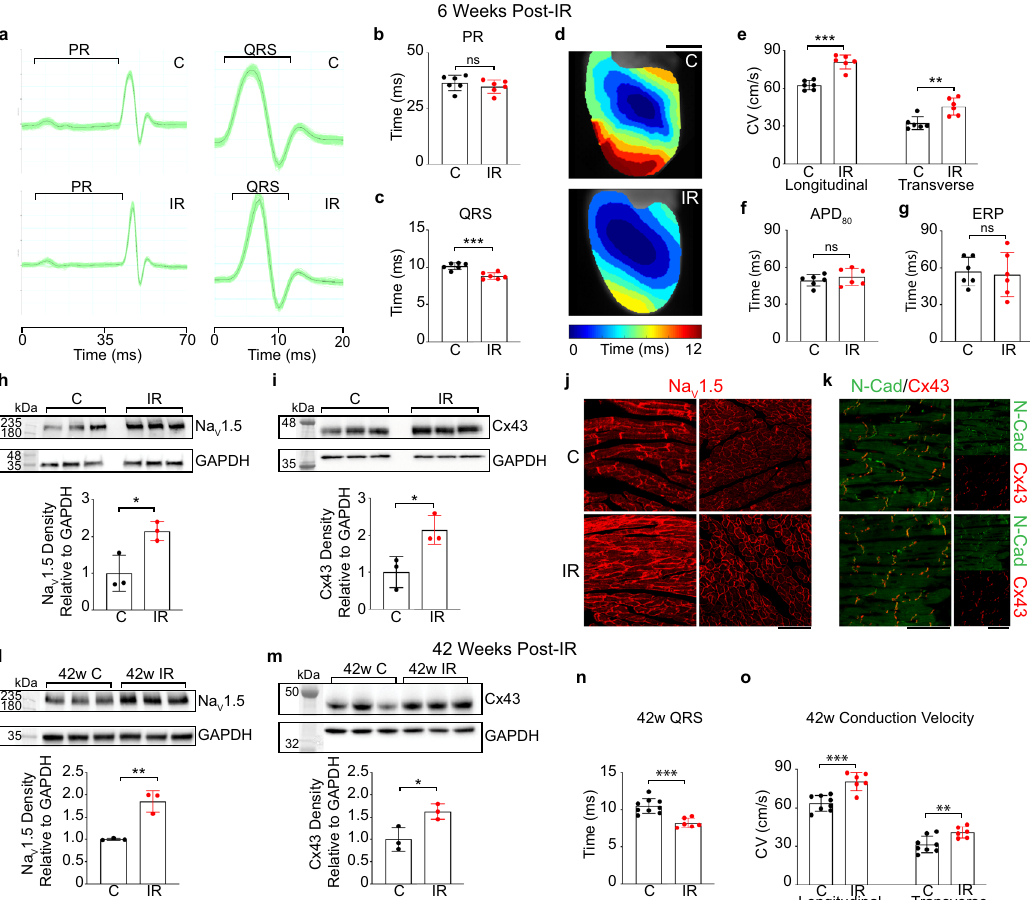
Fig. 2 Cardiac RT persistently increases adult murine ventricular conduction. a Representative ECGs from control (top) and IR mice (bottom) highlighting PR and QRS intervals. b , c Effect of radiation on PR ( P = 0.39) and QRS (** P = 0.00043) intervals in control (black) versus IR (red) mice ( n = 6 biologically independent animals per condition). d Representative ventricular activation maps from control and IR mice. Scale bars = 3 mm. e Effect of RT on ventricular CV ( n = 6 biologically independent animals per condition; *** P = 0.00005; ** P = 0.0034). f , g APD 80 ( P = 0.39) and ERP ( P = 0.78) in control versus IR mice ( n = 6 biologically independent animals per condition). h , i Western blots of Na V 1.5 (* P = 0.022) and Cx43 (* P = 0.025) in control and IR ventricles ( n = 3 biologically independent samples per condition). j Immunostaining of control (top) and IR (bottom) myocardium for Na V 1.5 and k co-stained for Cx43 (red) and N-Cadherin (green). Scale bars = 70 μ m. Experiment was replicated three times in biologically independent specimens and produced similar results. l , m Western blots of Na V 1.5 (** P = 0.0034) and Cx43 (* P = 0.027) after 42 weeks post-IR ( n = 3 biologically independent samples per condition). n Effect of RT on QRS intervals in control versus IR mice after 42 weeks (*** P = 0.00027; C, n = 9; IR, n = 6). o Left ventricular CVs in control ( n = 9 biologically independent animals) versus IR ( n = 6 biologically independent animals) mice at 42 weeks post-IR (*** P =